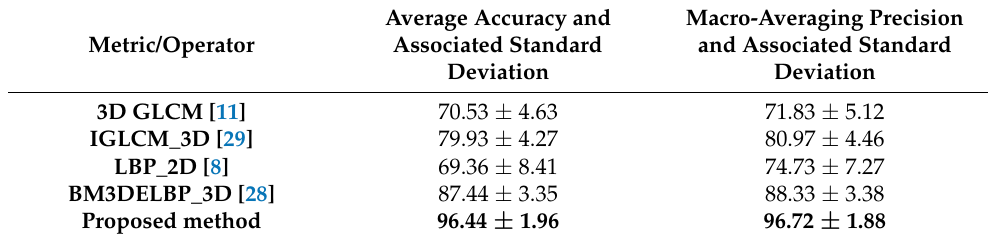
Table 6. Classification results for the first experiment with the RF classifier